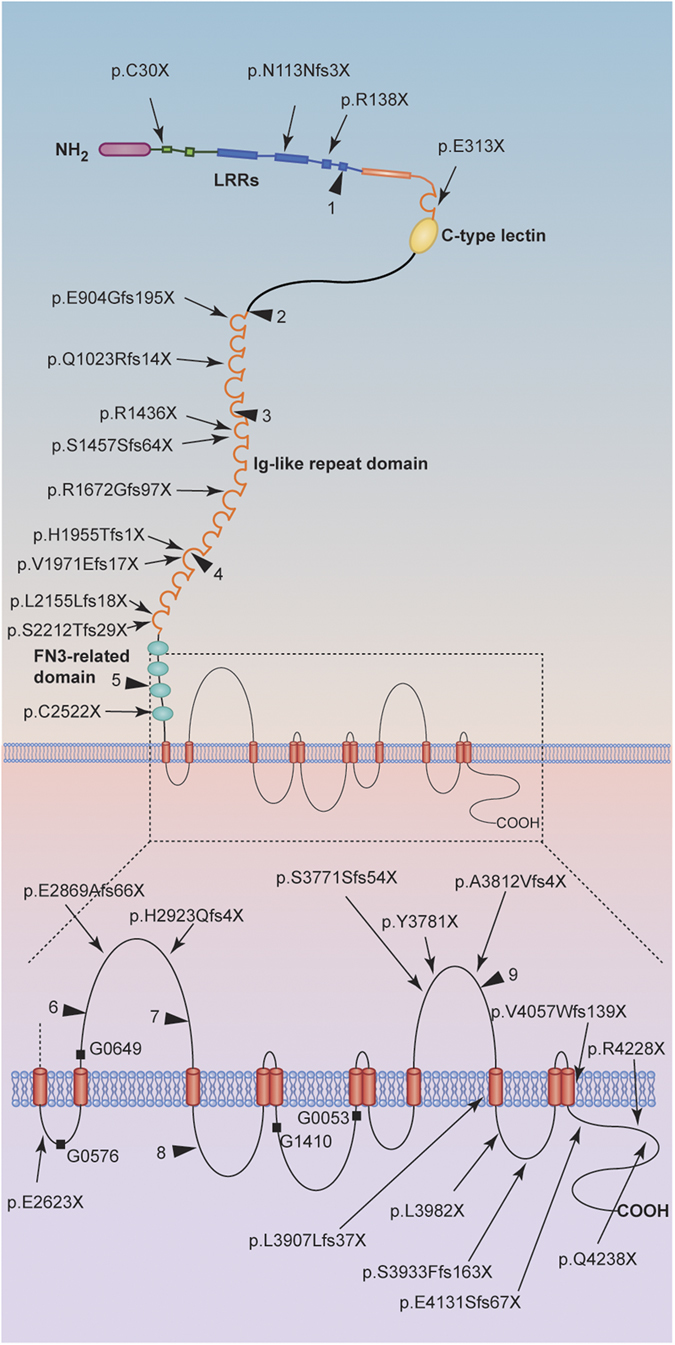
Schematic representation of polycystin-1, representing the location of mutations found in this study or previous reports (adapted by permission from Macmillan Publishers Ltd: [NATURE GENETICS], Hugheset al.19954).Nonsense mutations and frameshift mutations are indicated with arrows. The positions of in-frame deletions and splicing changes are indicated with boxes (G0576: c.8017-2-1delAG; G0649: c.8157-8159delCAC; G1410: c.10220 + 2T > C; G0053: c.10617 + 1delG). Likely pathogenic mutations are indicated with triangles (1–9: see Table 3 for details).